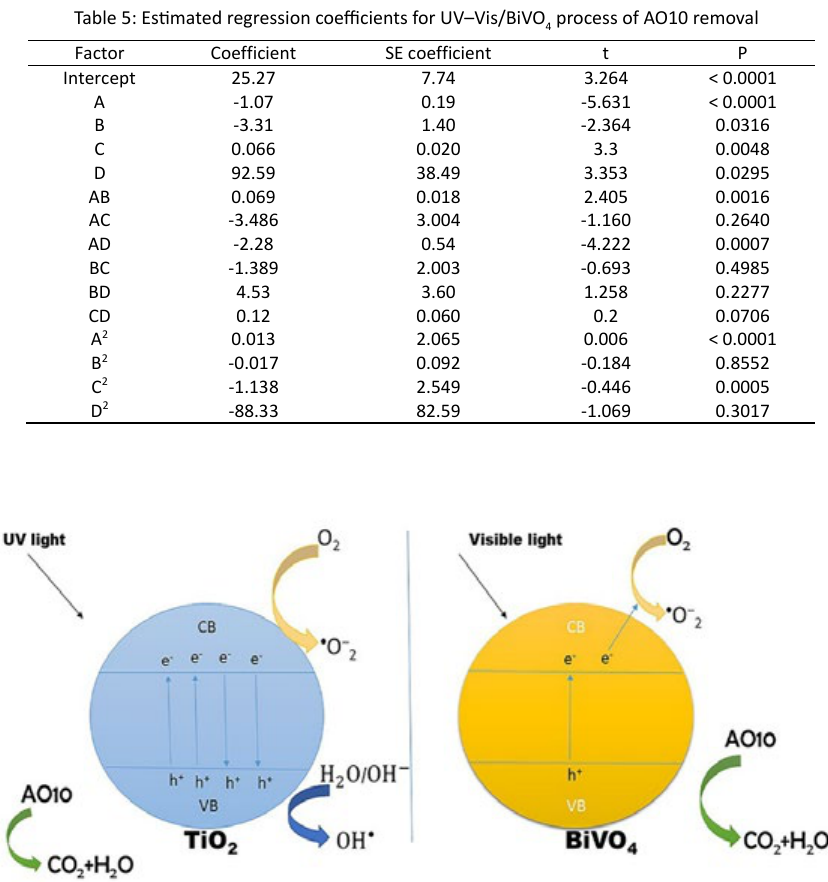
Fig. 8: Photocatalytic mechanism of TiO 2 and BiVO 4 nanoparticles (Martinez‐de La Cruz and Perez, 2010; Nakata and Fujishima, 2012; Roy et al. , 2011